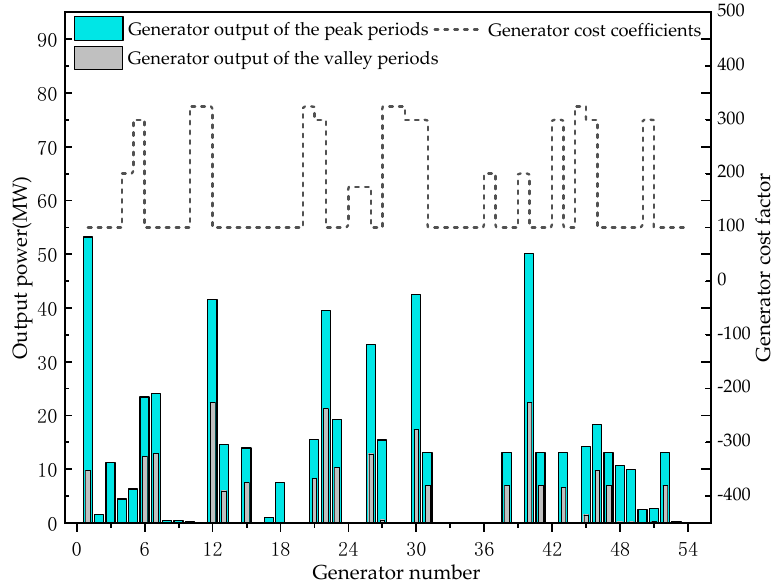
Figure 7. Generator active output power at peak and valley periods and generator cost factors.